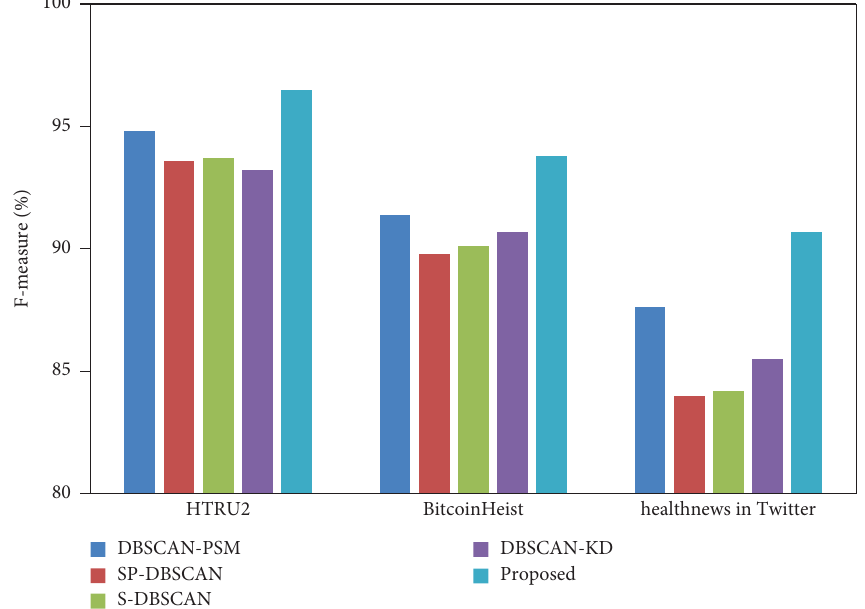
Figure 9: Comparison of clustering accuracy of diferent algorithms in 3 datasets.